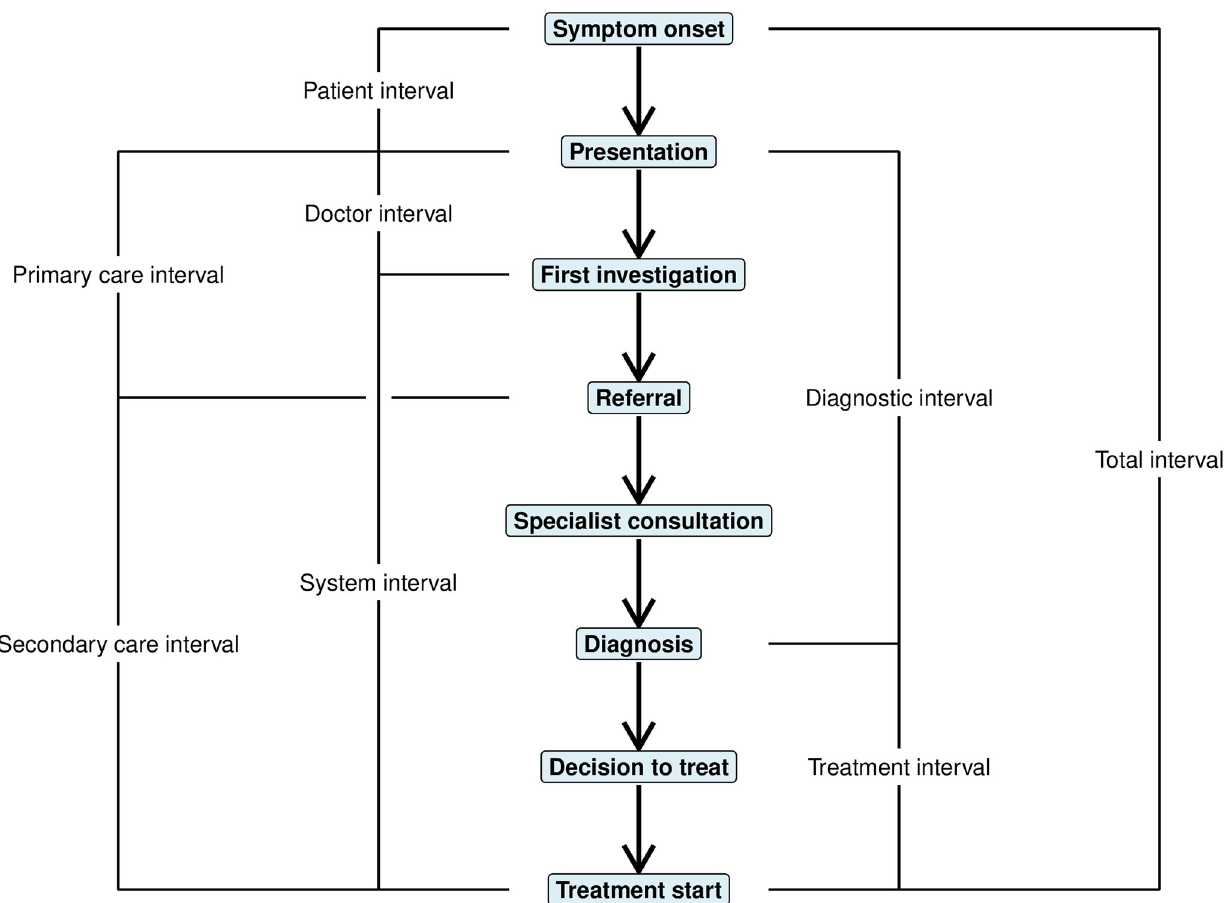
Fig 1. The pathway to treatment. Time points and intervals of interest along the pathway to treatment from symptom onset for patients with colorectal cancer. Intervals are derived from the Aarhus Statement on improving the design and reporting of studies on early cancer diagnosis